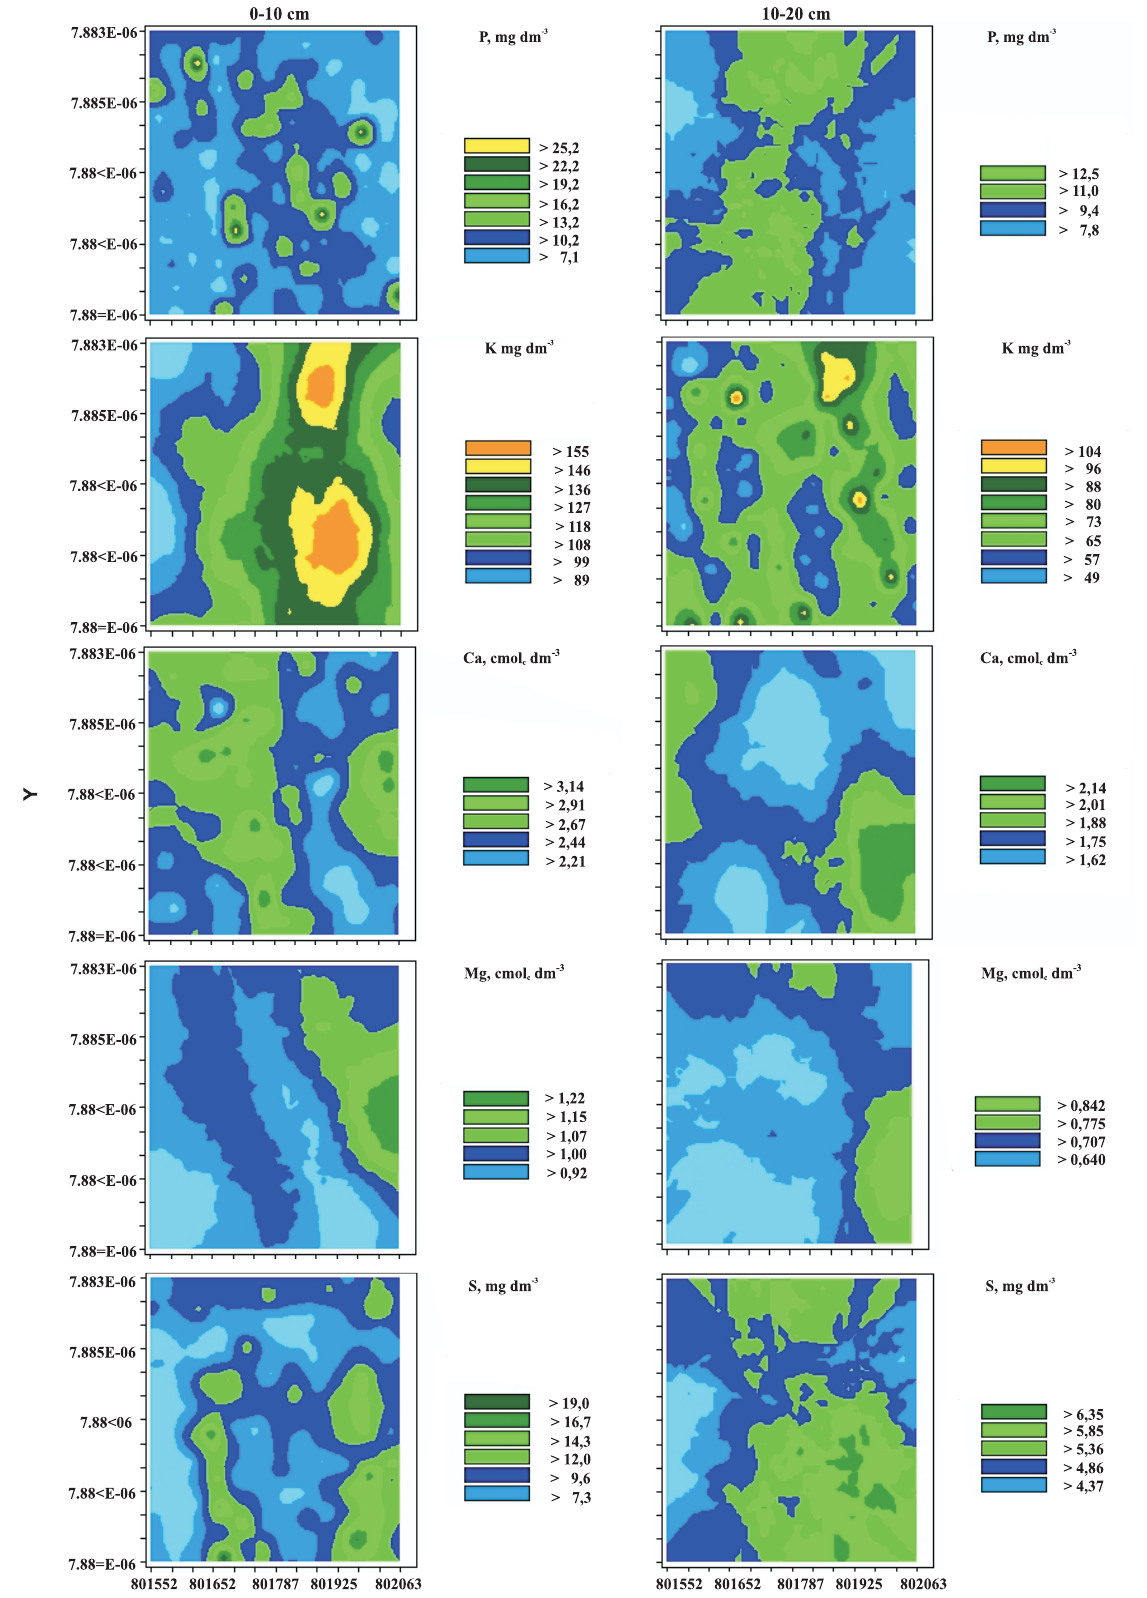
Figura 1. Mapas de isolinhas de teores de macronutrientes em diferentes camadas de um Latossolo Vemelho textura muito argilosa, sob sistema plantio direto (Fazenda Santa